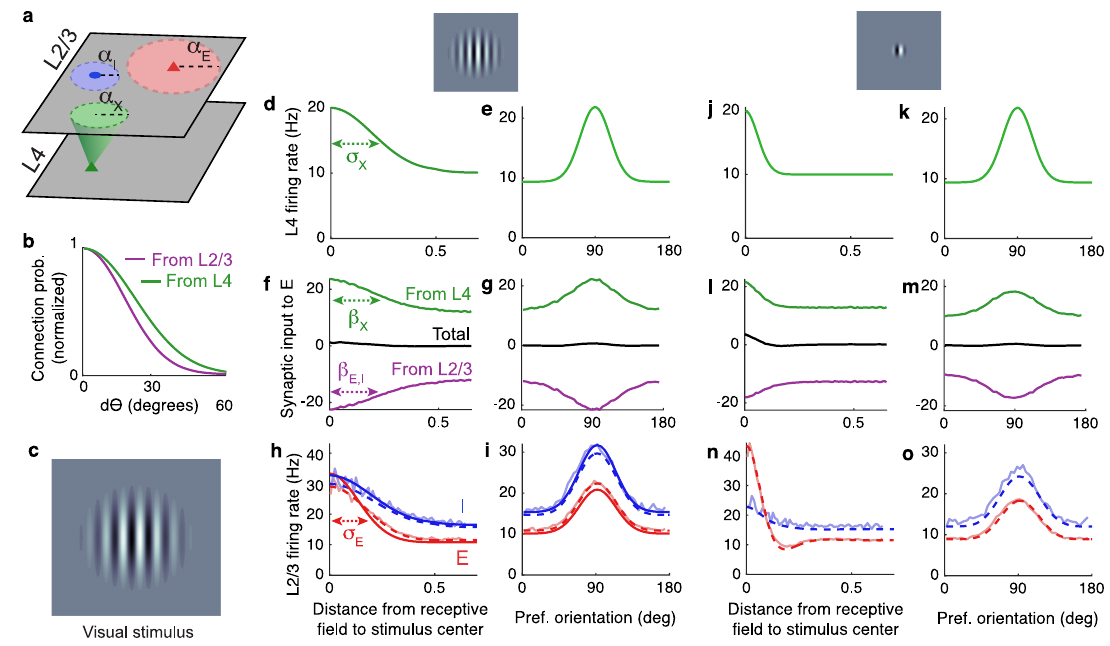
Fig 5. Response properties of a continuously indexed network. a) Network diagram. Poisson spiking neurons in L4 ( X ) provide external synaptic input to 2 × 10 5 recurrently connected excitatory and inhibitory AdEx model neurons ( E and I ) in L2/3. The spatial width of synaptic projections from population a = X , E , I is given by β . b) Neurons are assigned random orientations and connection a probability also depends on the difference, dθ , between neurons’ preferred orientation. c) An oriented stimulus in the animal’s visual field. d,e) The location of the stimulus is modeled by firing rates in L4 that are peaked at the location of the stimulus in physical and orientation space. f,g) Synaptic current to neurons in population E from the external network (green), the local network (purple) and total (black) as a function distance from the receptive field center and as a function of neurons’ preferred orientation. h,i) Firing rate profiles of excitatory (red) and inhibitory (blue) neurons in the local network from simulations (light curves), classical balanced network theory (solid, dark curves; from Eq (13)) and under the linear correction (dashed; from Eq (17)) in physical and orientation space. j-o) Same as (d-i) except for a smaller visual stimulus, modeled by a narrower spatial firing rate profile in L4. Firing rates from Eq (13) are not shown in panels n and o because balance cannot be realized and Eq (13) cannot be applied when external input is narrower than recurrent connectivity (see main text, S1 Text, and [8]).